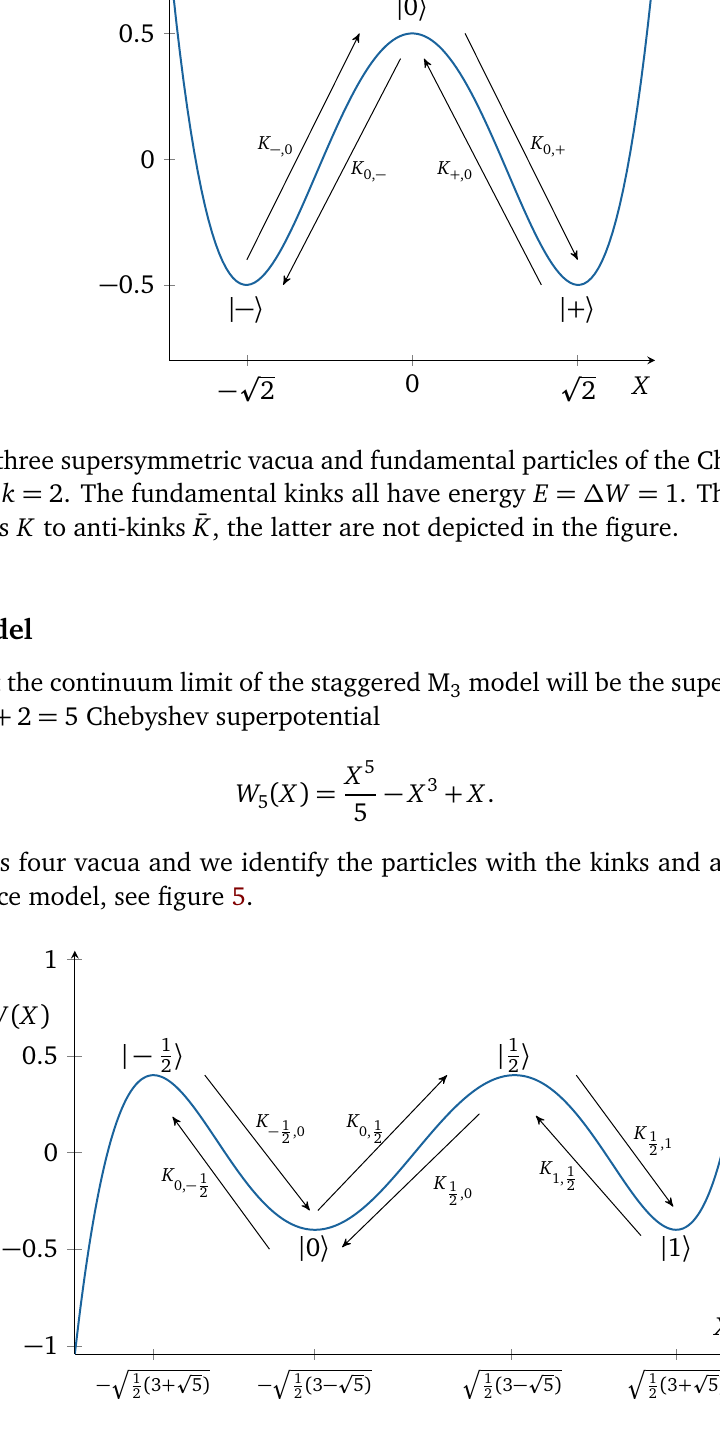
Figure 5: The four supersymmetric vacua and fundamental particles of the Chebyshev super- potential with k = 3. The fundamental kinks all have energy E = ∆ W = 0.8. The supercharges relate the kinks K to anti-kinks ¯ K , the latter are not depicted in the